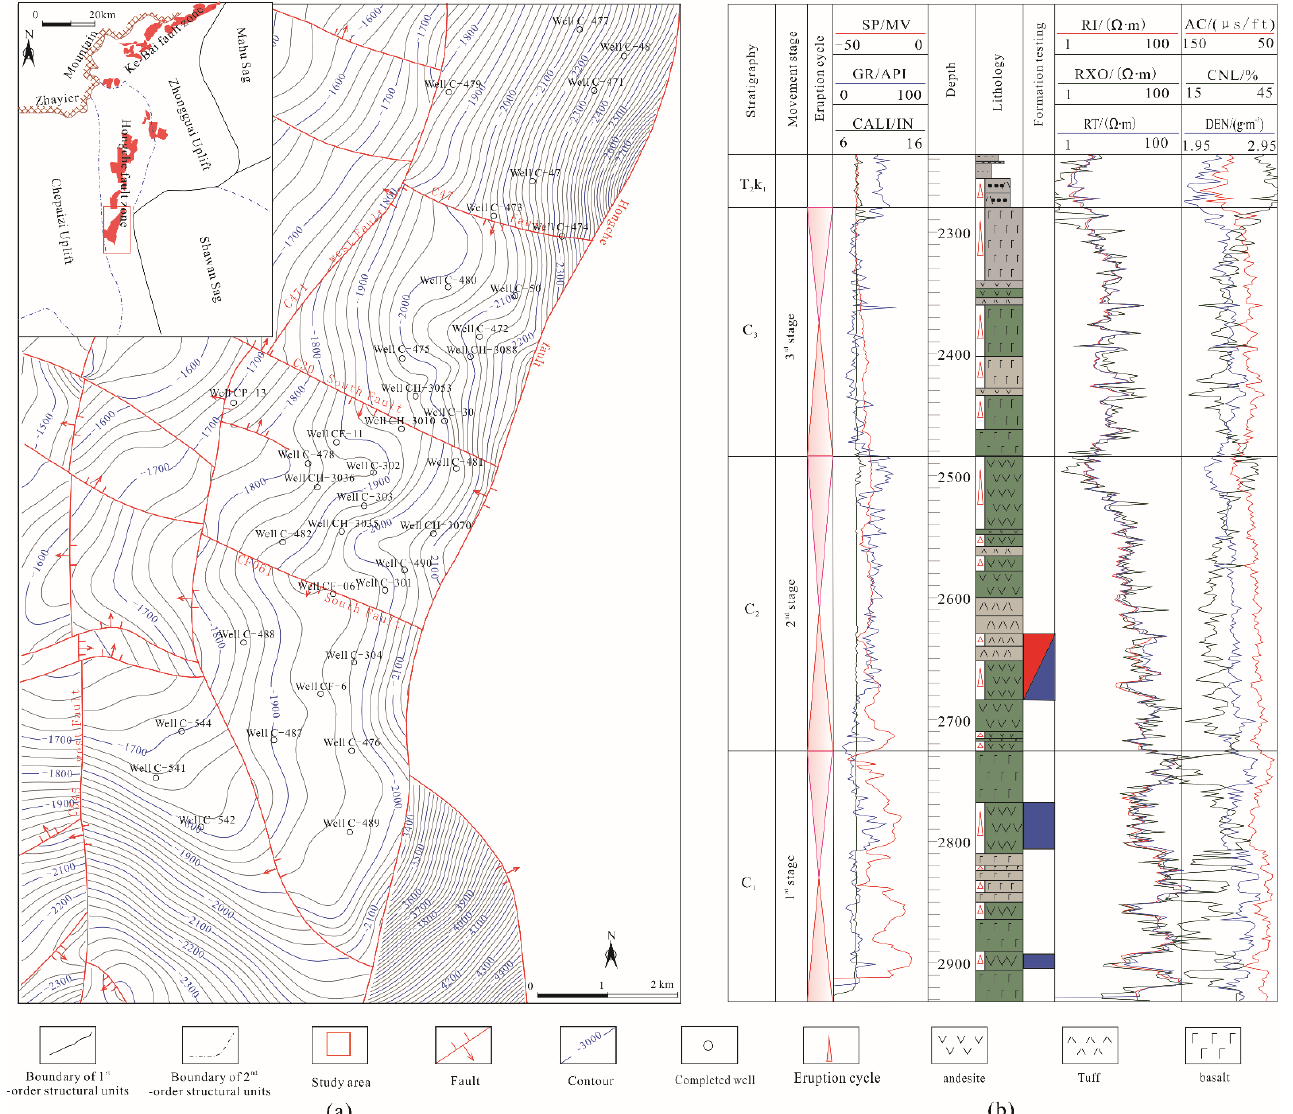
Figure 1. Structural position of the study area ( a ) and the stratigraphic column of the Carboniferous ( b